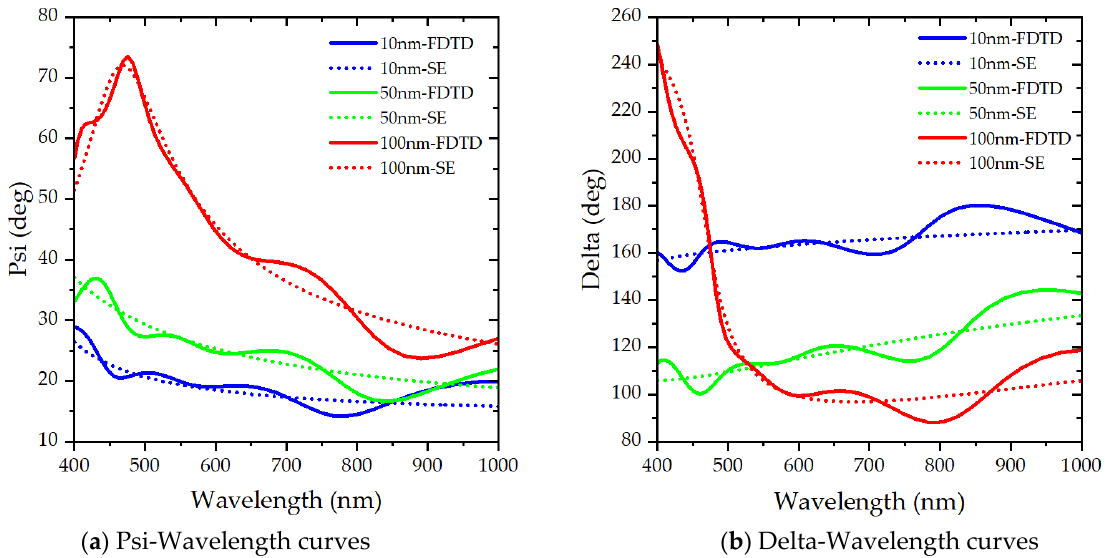
Figure 4. Comparison of the ellipsometric parameters between FDTD simulation and forward modeling of smooth films of SiO 2 films with thickness of 2 nm, 50 nm, and 100 nm on silicon substrate under 65° incident angle.